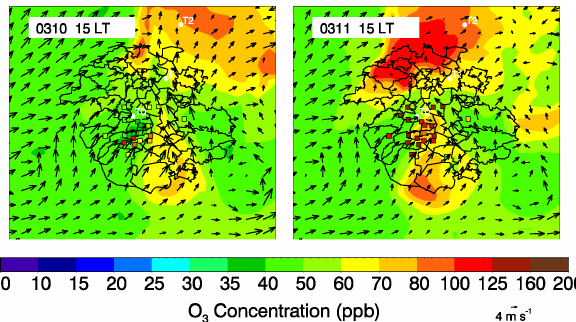
Fig. 5 1223 Fig. 5. Spatial distribution of ground O 3 concentration at 15:00LT 1224 on 10 and 11 March. Colored squares represented RAMA observa- tions, and colored contour and black arrows are simulated O 3 and wind fields,